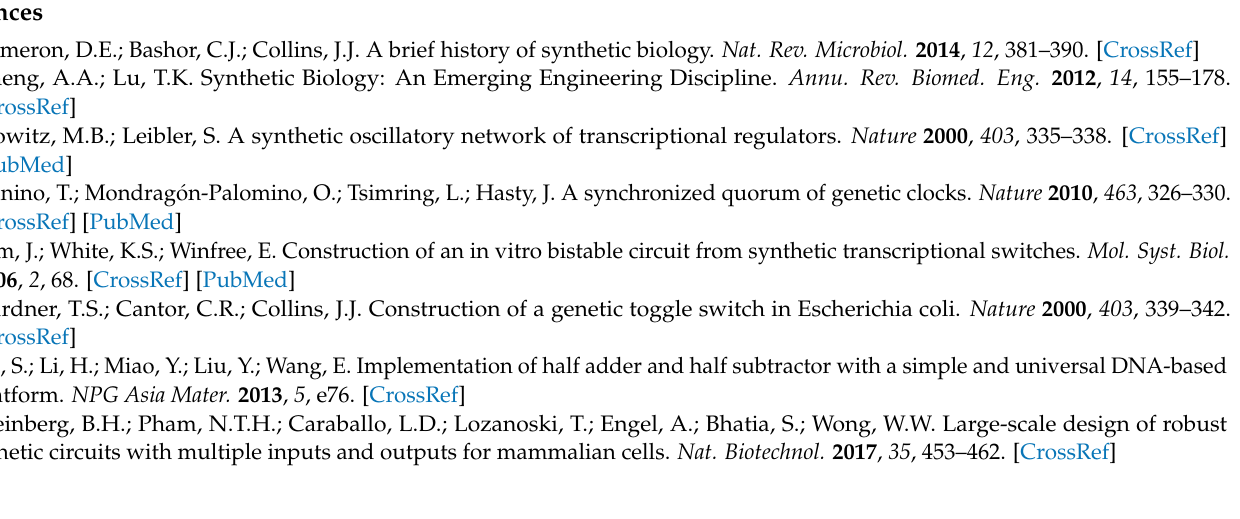
Table S7: promoter sequences used in this study, Table S8: insert sequences used in this study, Table S9: other Accessary sequences used in this study, Figure S1: in vivo characterization of the X to Z activation in the RNA-only IFFL circuit, Figure S2: RNA secondary structures for four different variants of Y in the RNA-only IFFL circuit, Figure S3: in vivo characterization of the RNA-only IFFL circuit, Figure S4: RNA-only IFFL experiment and simulation, Figure S5: RNA-only IFFL experiment and simulated GFP data for different IPTG and Arabinose concentrations, Figure S6: simulated RNA- only IFFL circuit for different combinations of IPTG and Arabinose concentrations, Figure S7: RNA– protein hybrid IFFL simulation and experimental GFP data, Figure S8: experimental results for RNA–protein hybrid